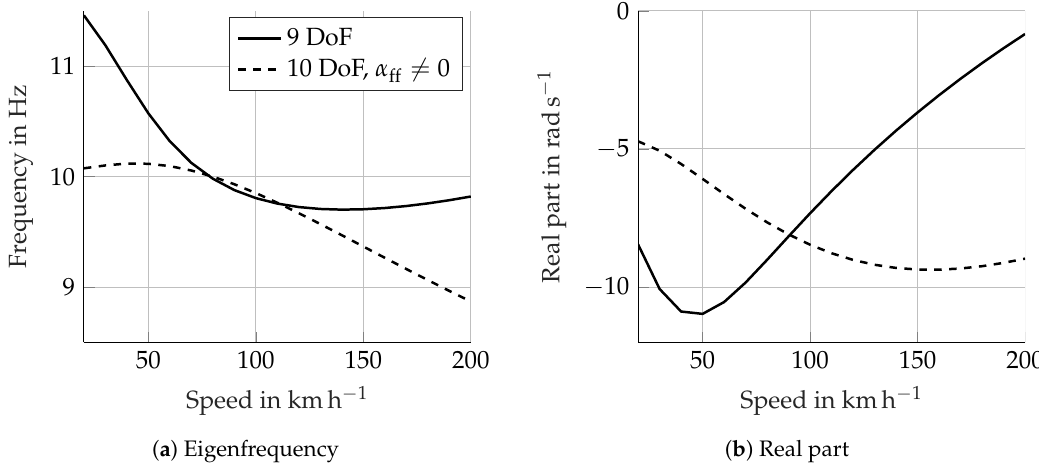
Figure 4. Influence of front fork flexibility on wobble.